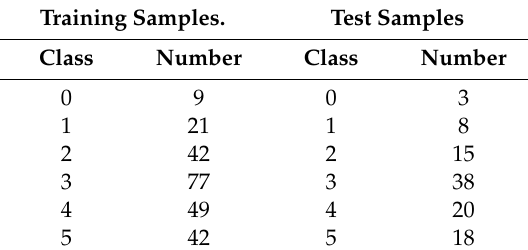
Table 3. Label result and number of samples.